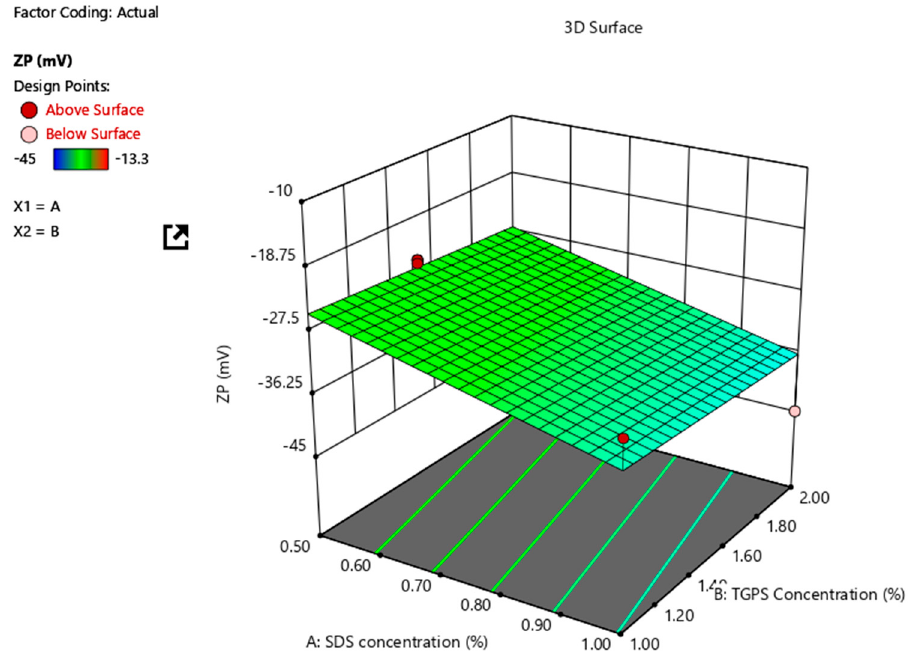
Figure 3. 3D response surface plot depicting the impact of SDS and TPGS 1000 concentration on ZP of the NCC.